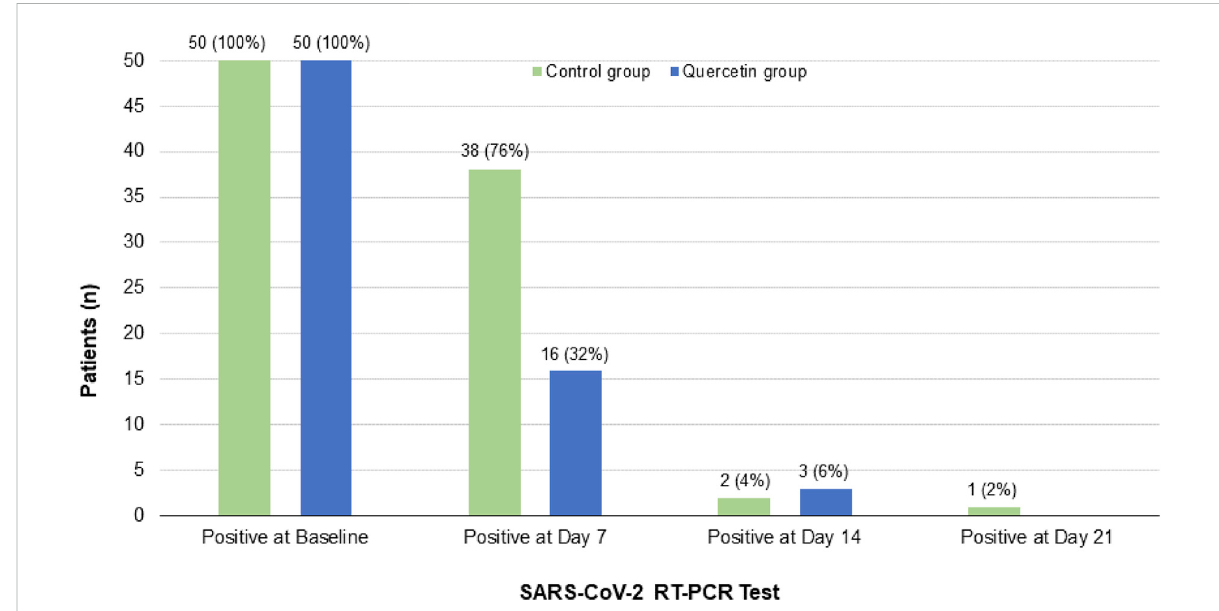
FIGURE 3 Patient ’ s follow-up RT-PCR COVID-19 test results in the two treatment groups.